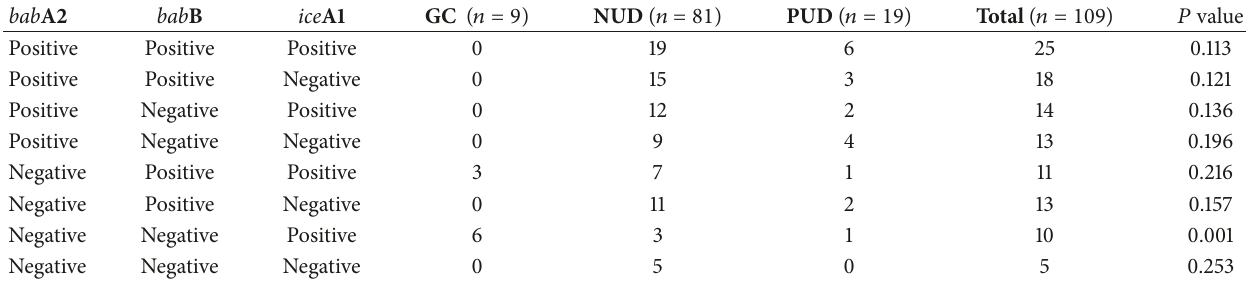
Table 3: Combination of bab A2 , bab B , and ice A1 genotypes and clinical